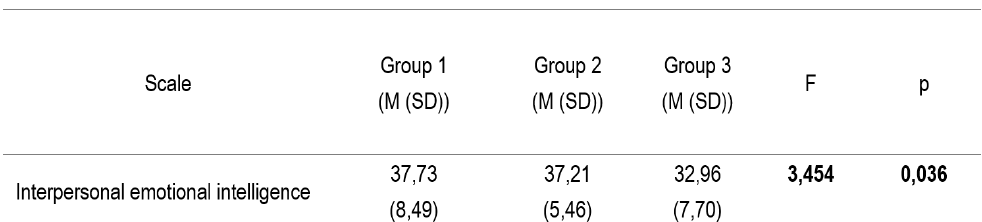
Indicators of emotional intelligence of mentors with different levels of success (N =